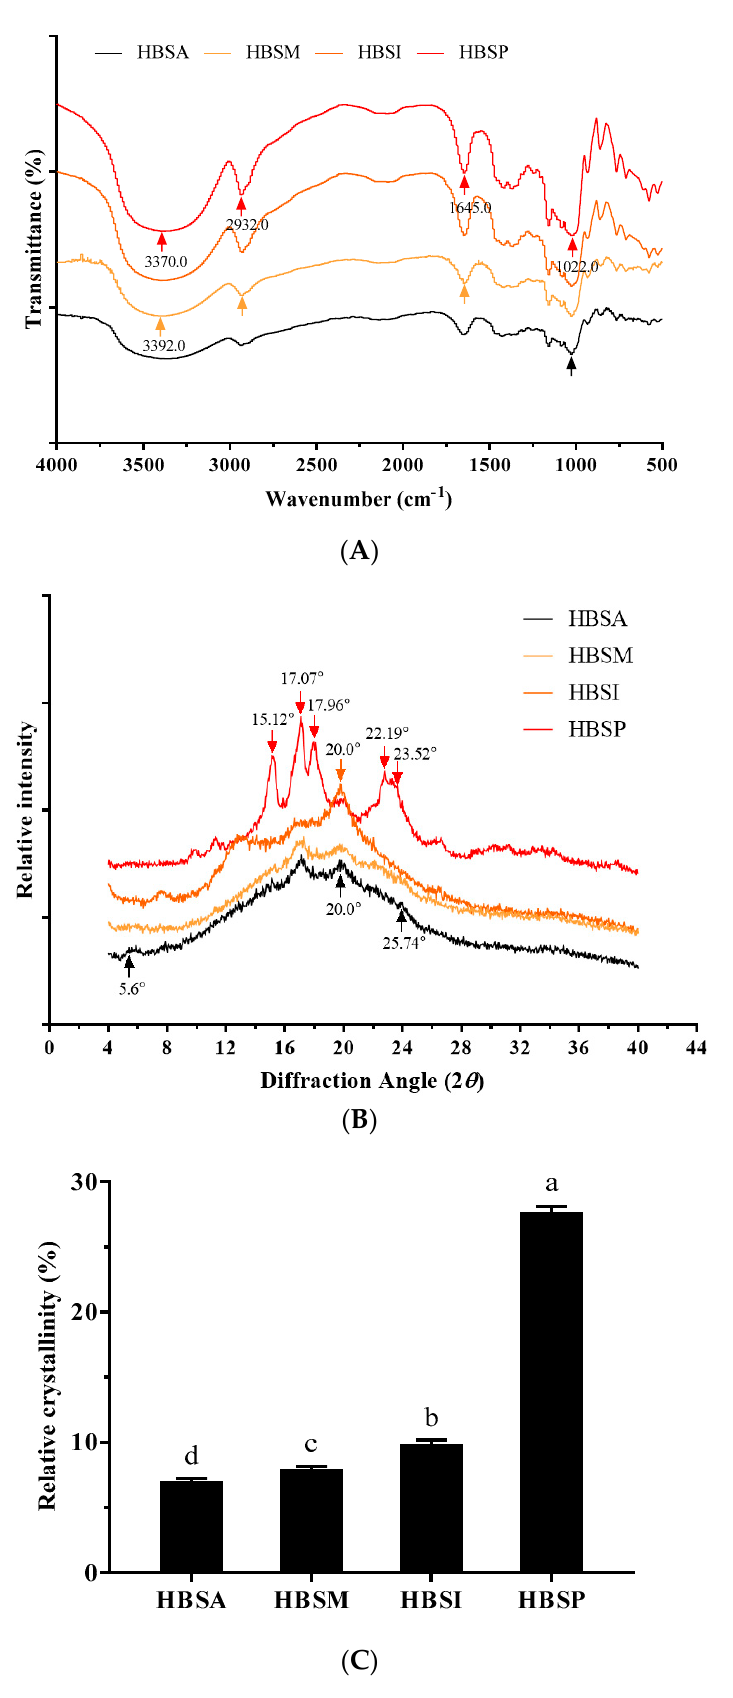
Figure 2. FT-IR spectra ( A ), XRD patterns ( B ), and relative crystallinities ( C ) of HBSA, HBSM, HBSI, and HBSP. Values with different lowercase letters were significantly different ( p < 0.05).